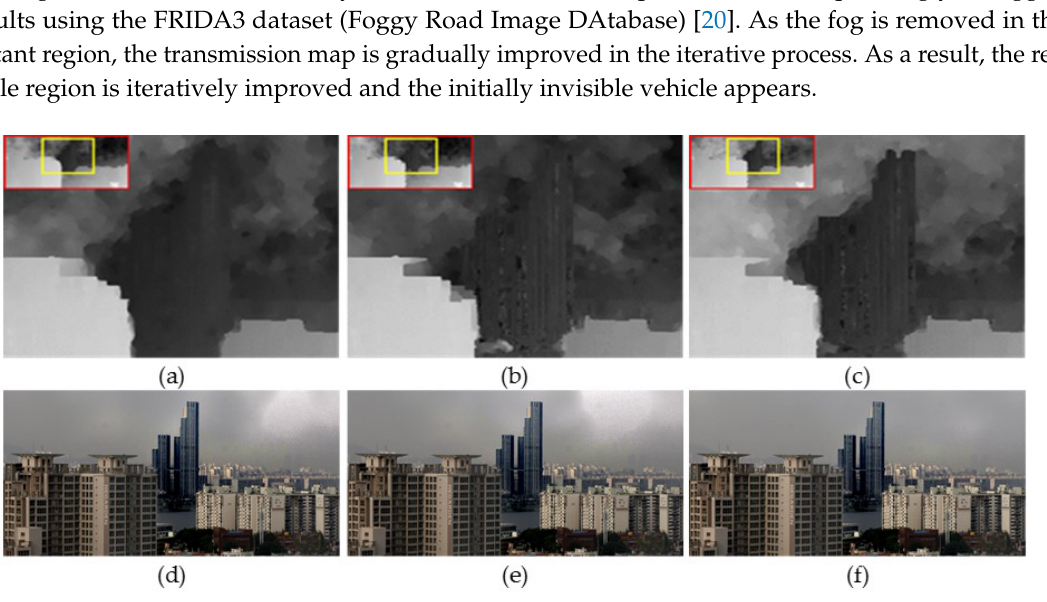
Figure 4. Iterative refinement process of transmission map. ( a – c ) The 1-st, 3-rd, and 5-th refined transmission maps; and ( d – f ) the 1-st, 3-rd, and 5-th defogged results.